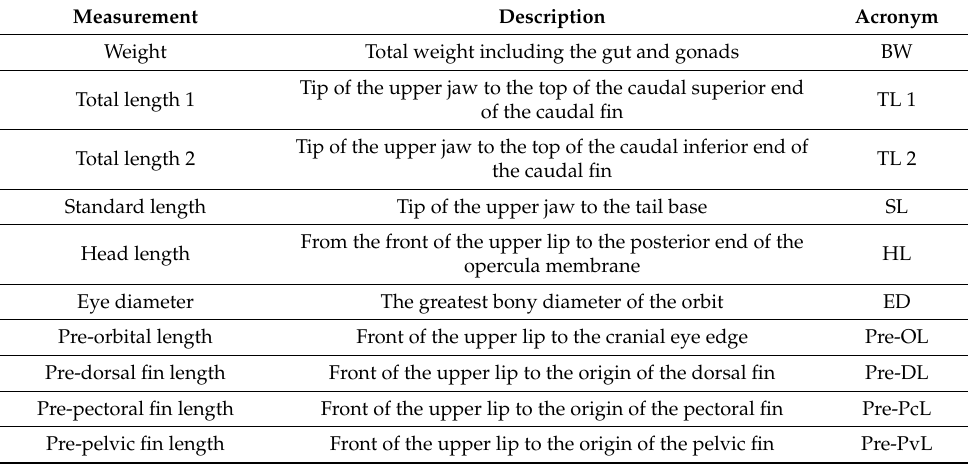
Table 2. Morphometric measurements and meristic counts used to assess Brycon dentex in this study.